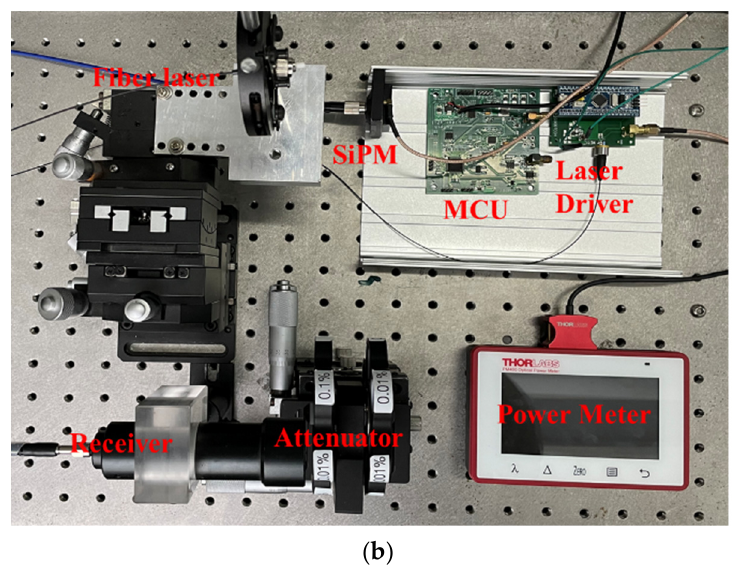
Figure 4. ( a ) Schematic of the LiDAR system based on SiPM. ( b ) Experimental platform.